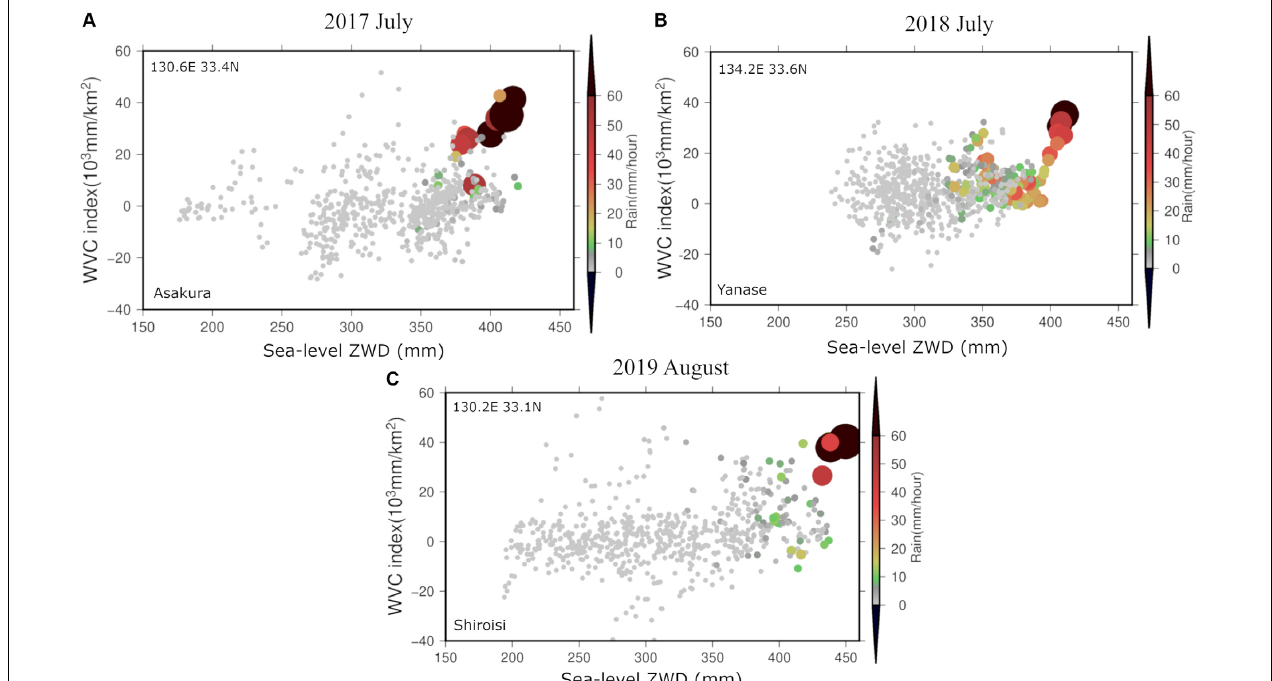
FIGURE 8 | Distribution of hourly values of WVC (vertical axis), sea-level ZWD (horizontal axis), and hourly rain rate (color and circle size) for July 2017 (A) , July 2018 (B) , and August 2019 (C) . The rain rate was measured at the Asakura, Yanase, and Shiroishi AMEDAS stations, respectively, and WVC and ZWD are the values at their nearest grid points (coordinates given at the upper left corners).